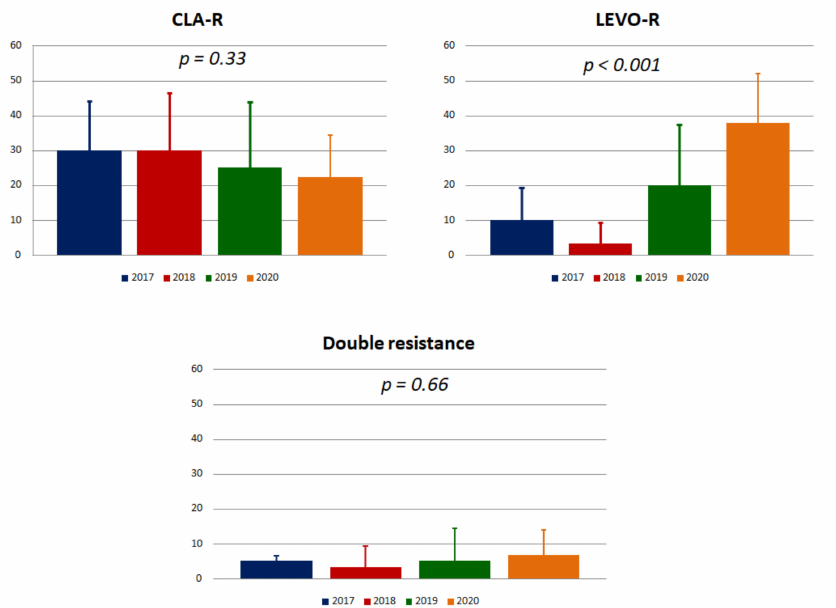
Figure 1. Trends of clarithromycin and levofloxacin resistance in naive patients from 2017 to 2020. Histograms show rates and standard deviation. CLA-R: resistant to clarithromycin; LEVO-R: resistant to